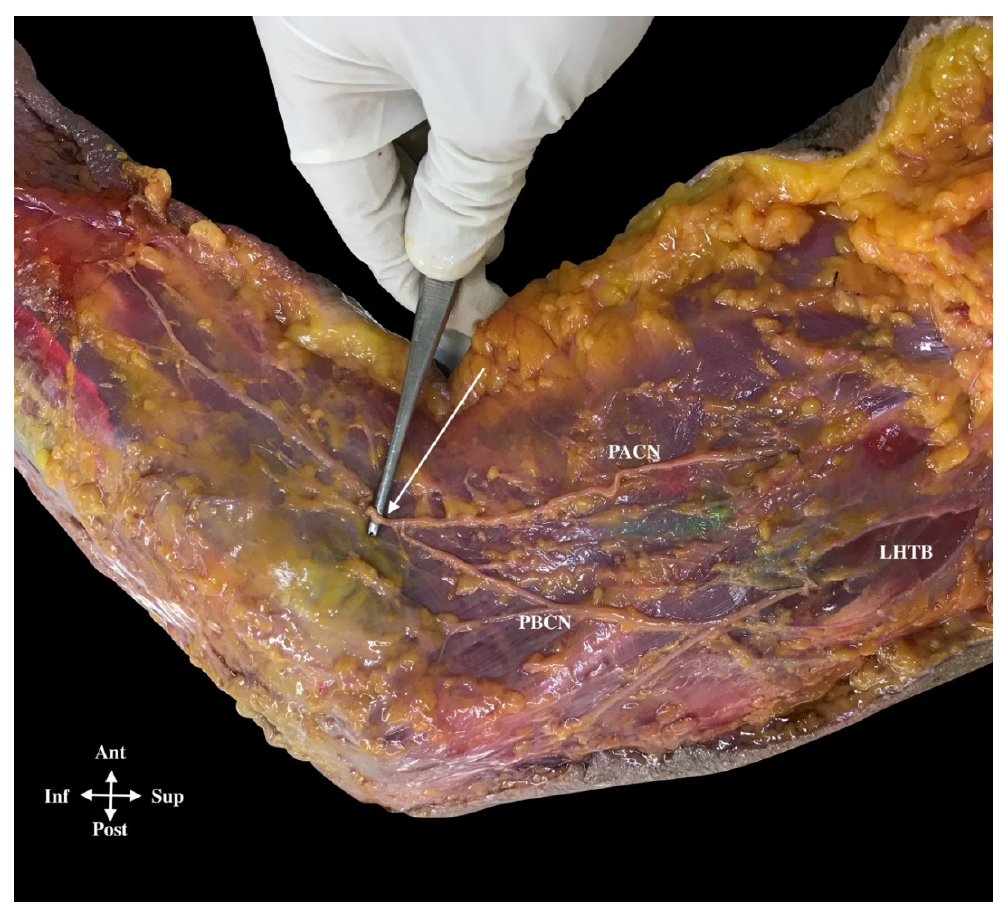
Figure 6. Anastomosis between the posterior antebrachial cutaneous nerve (PACN) (piercing the LIMS with the RN and then following in the anterior compartment) and the posterior brachial cutaneous nerve (PBCN). They form the only branch in the posterolateral side of the forearm (white arrow). Lateral head triceps brachii muscle (LHTB).